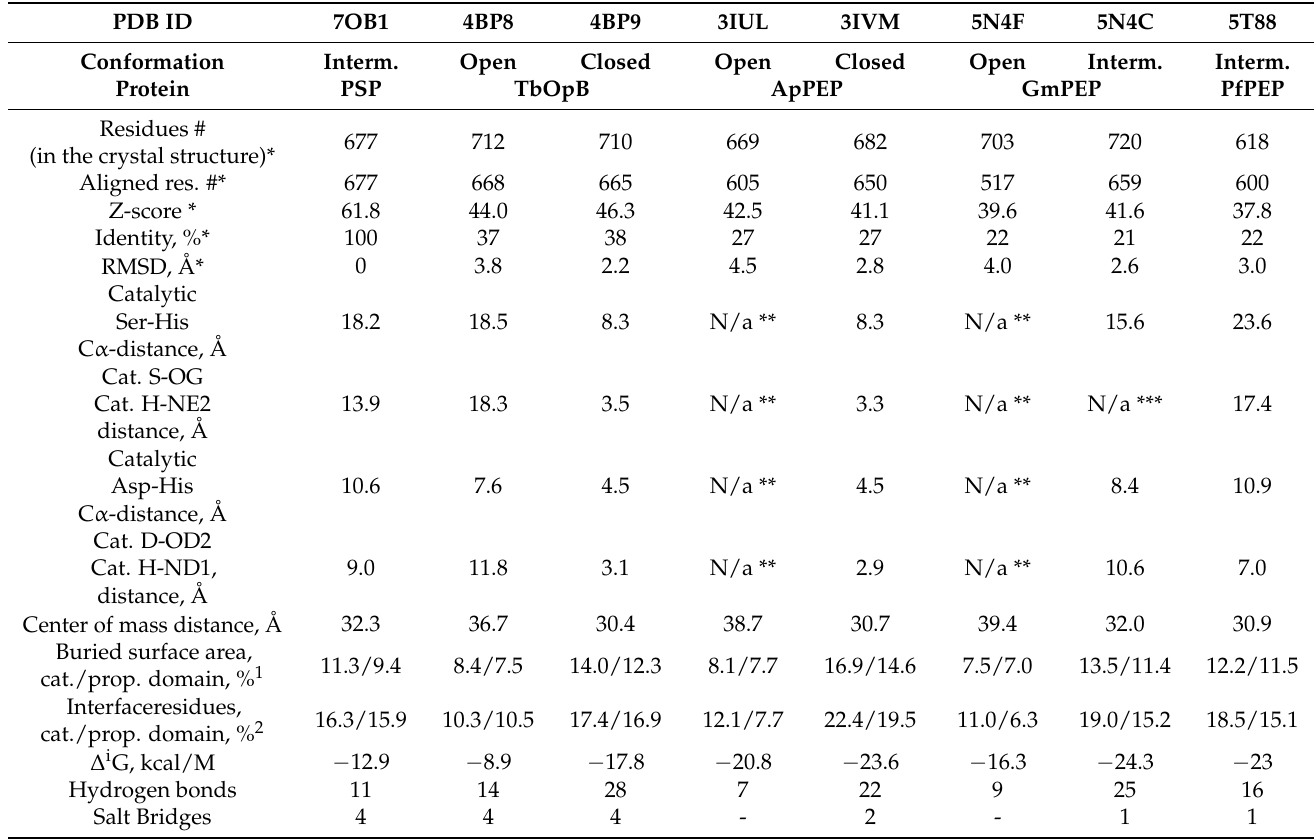
Table 3. Catalytic triad and domains positioning in the crystal structure of PSPmod and those of TbOpB, ApPEP, GmPEP and PfPEP crystallized in different conformational